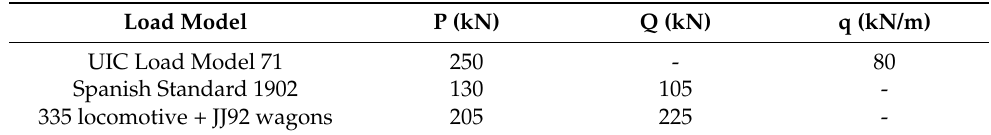
Table 2. Axle loads for each vehicle model analyzed.